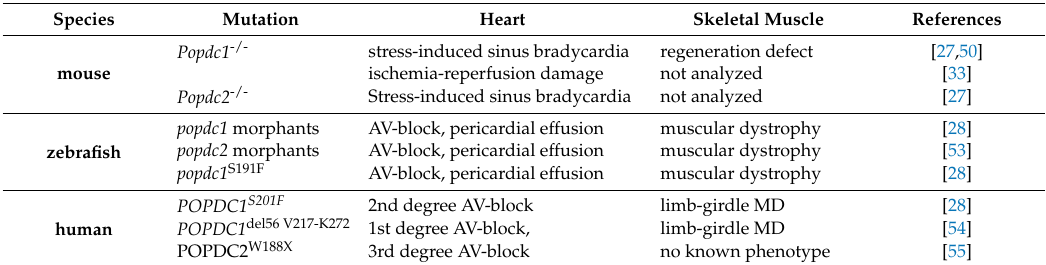
Table 1. Cardiac and skeletal muscle phenotypes in model organism and